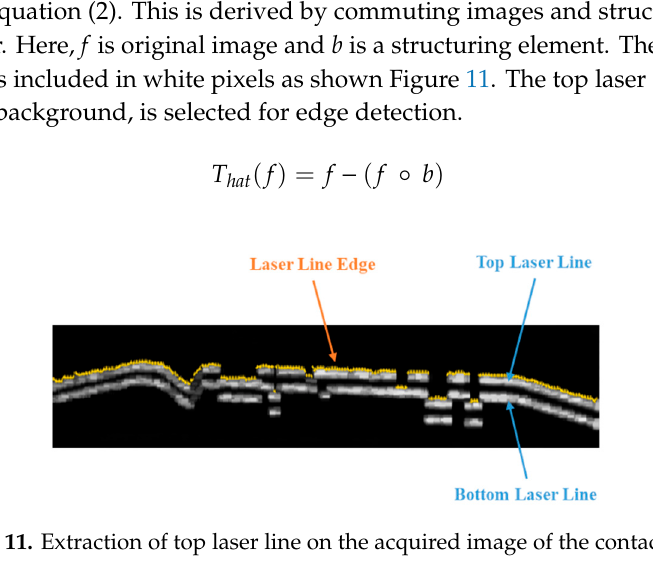
Figure 10. Detection of pantograph contact strip from R-CNN.